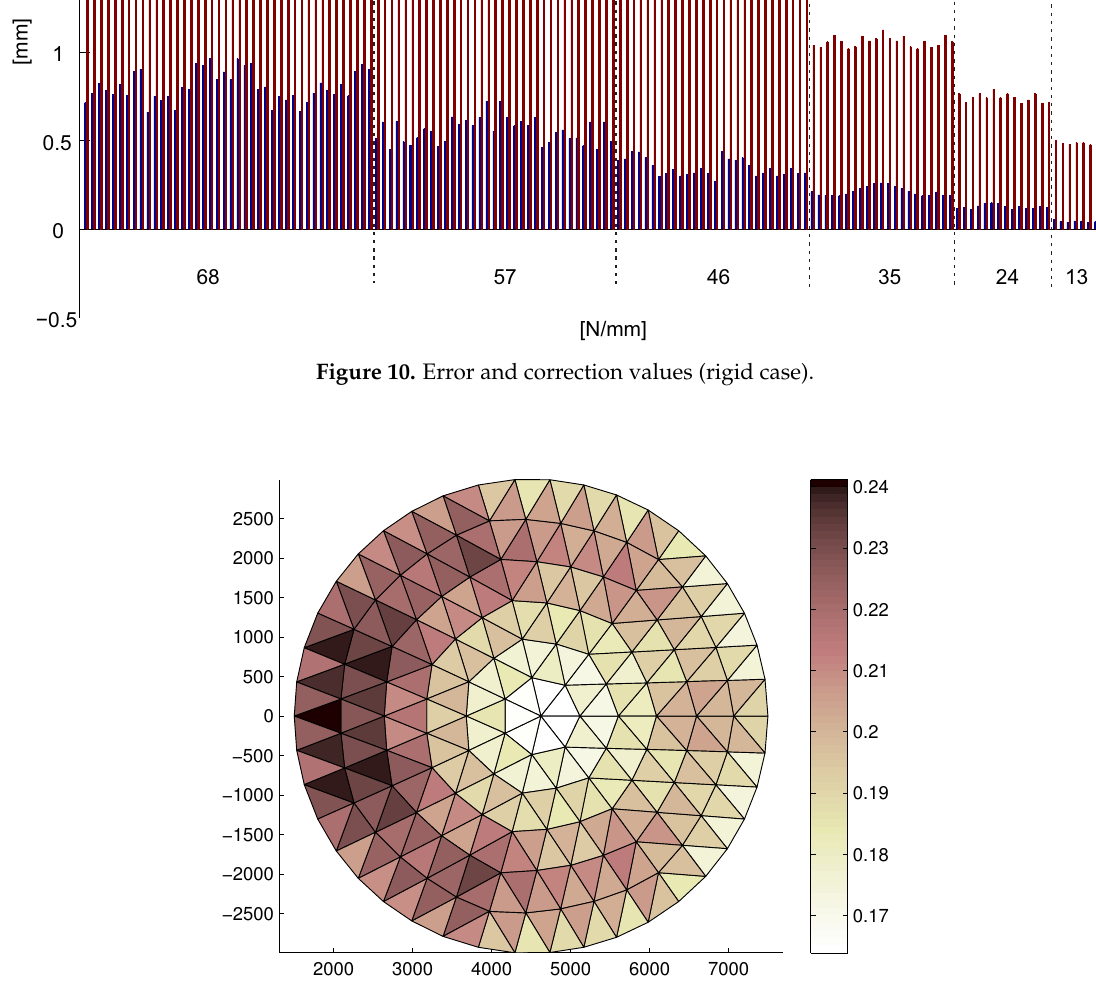
Figure 11. Faceting error (mm) distribution on the front tension truss, obtained for the rigid ring truss